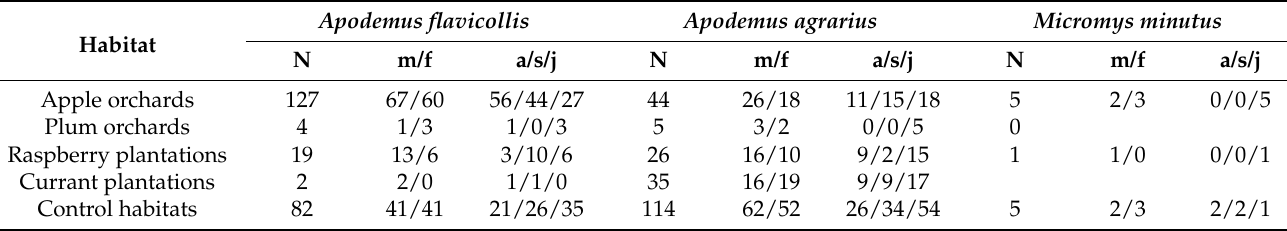
Table 2. Sample sizes by habitat of the three species of granivorous rodents used for stable isotope analysis. Abbreviations: N, number of analysed individuals; m/f, numbers of males and females; and a/s/j, numbers of adults, subadults, and juveniles,